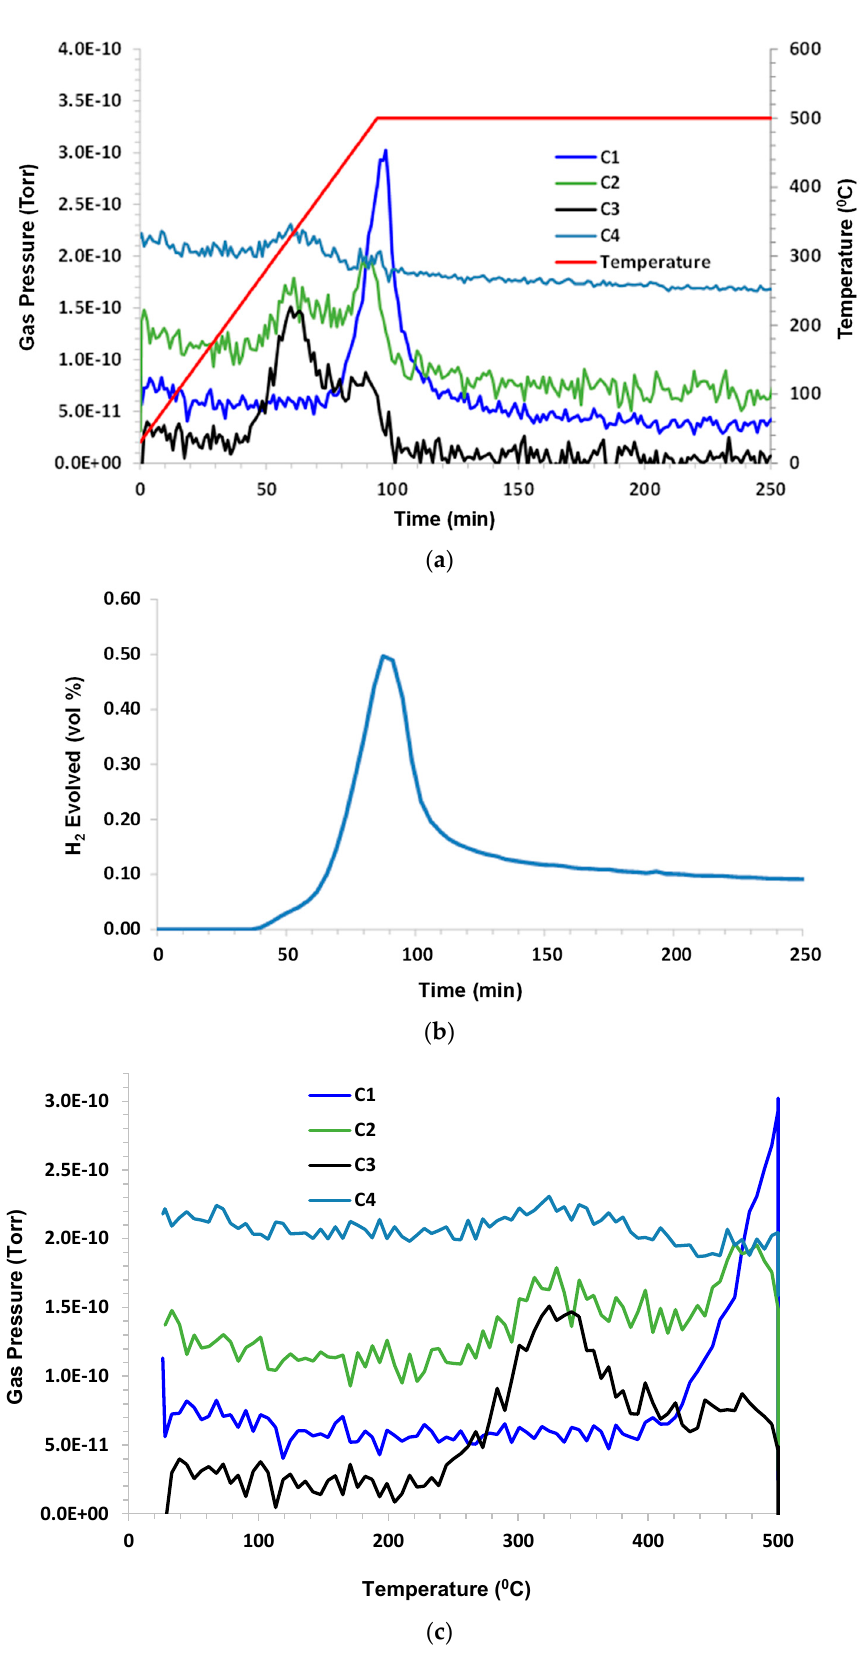
Figure 6. Chattanooga shale (2) in humid CO 2 . ( a ) Gas pressure and temperature as a function of time. ( b ) H 2 evolved (vol%) as a function of time. ( c ) Gas pressure as a function of temperature.